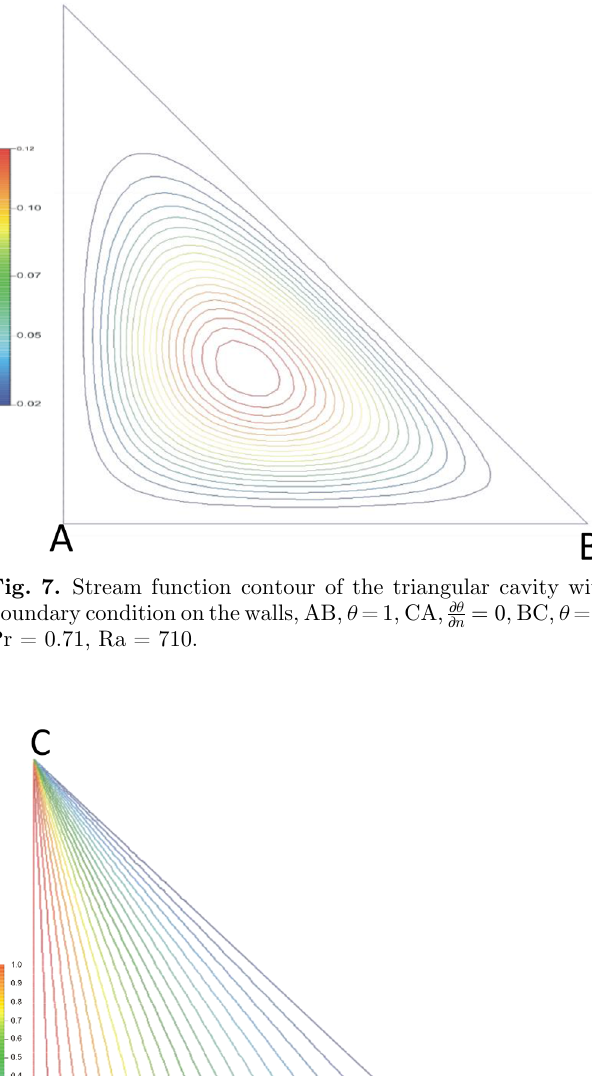
¼ 0 , BC, u =0, CA, u =1, n